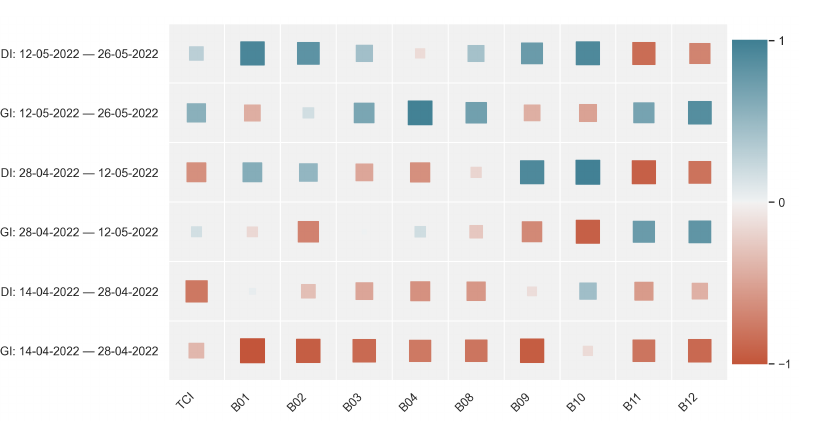
Figure 10. Example of 14-day window correlations.